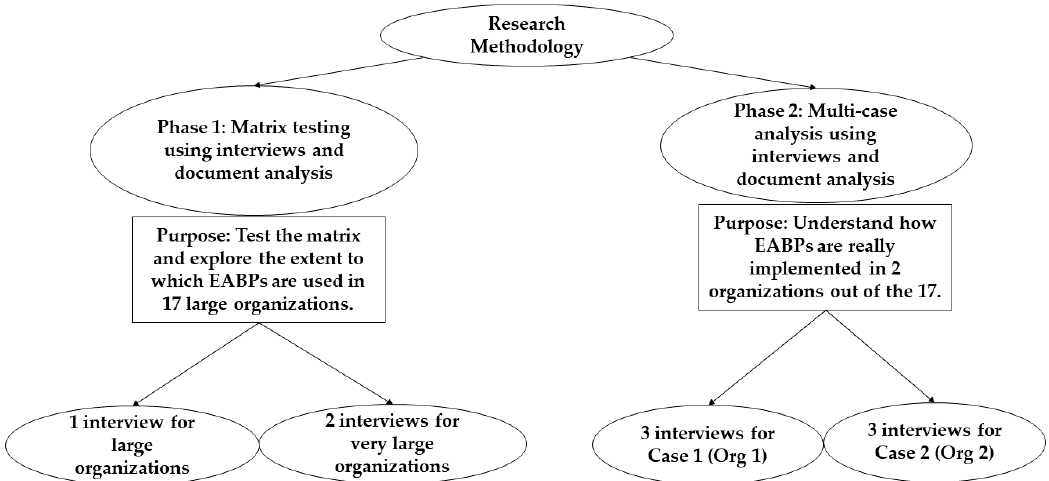
Figure 1. Outline of the research methodology .